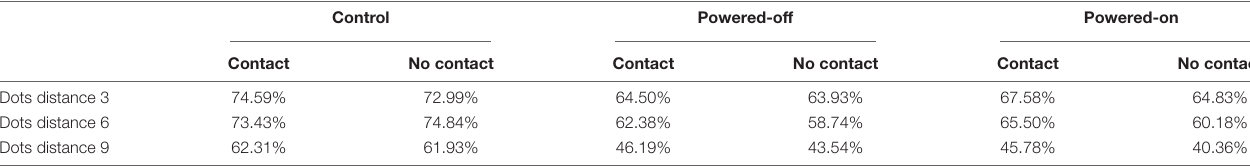
TABLE 2 | The hit rate detail across the experimental conditions in experiment